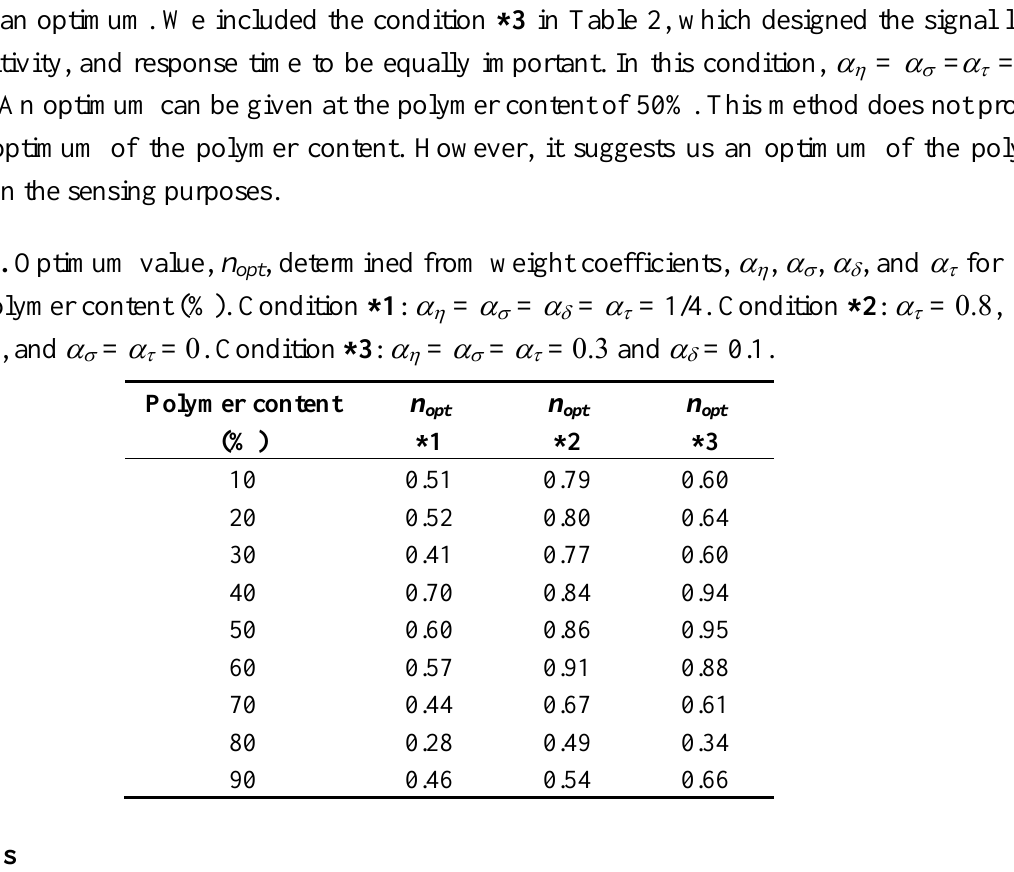
, determined from weight coefficients,  opt =  =  . Condition *3 :   